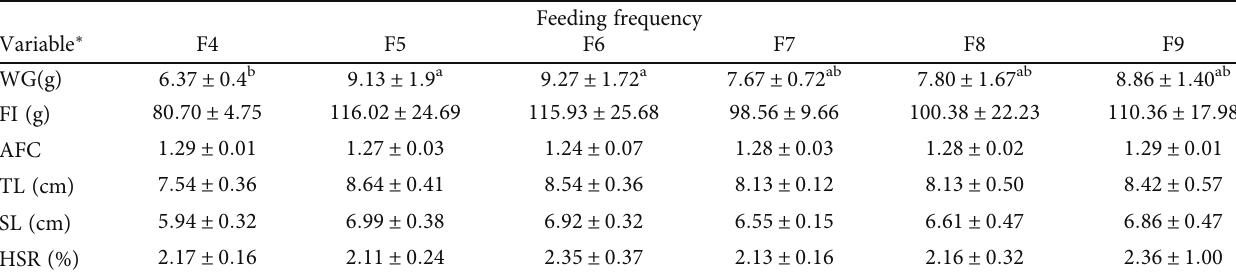
∗ Values without letters or with the same letters, which are on the same line, indicate that there was no signi fi cant di ff erence ( p > 0 : 05 ), whereas those with di ff erent letters indicate a signi fi cant di ff erence ( p < 0 : 05 ). F4: Fed 4 times a day; F5: fed 5 times a day; F6: fed 6 times a day; F7: fed 7 times a day; F8: fed 8 times a day; F9: fed 9 times a day. Table 5: Contingency table of frequencies and distributions of muscle fi bers in three diameter classes (0-10 μ m, between 10 and 20 μ m, between 20 and 30 μ m, and between 30 and 40 μ m) in Nile tilapia fi